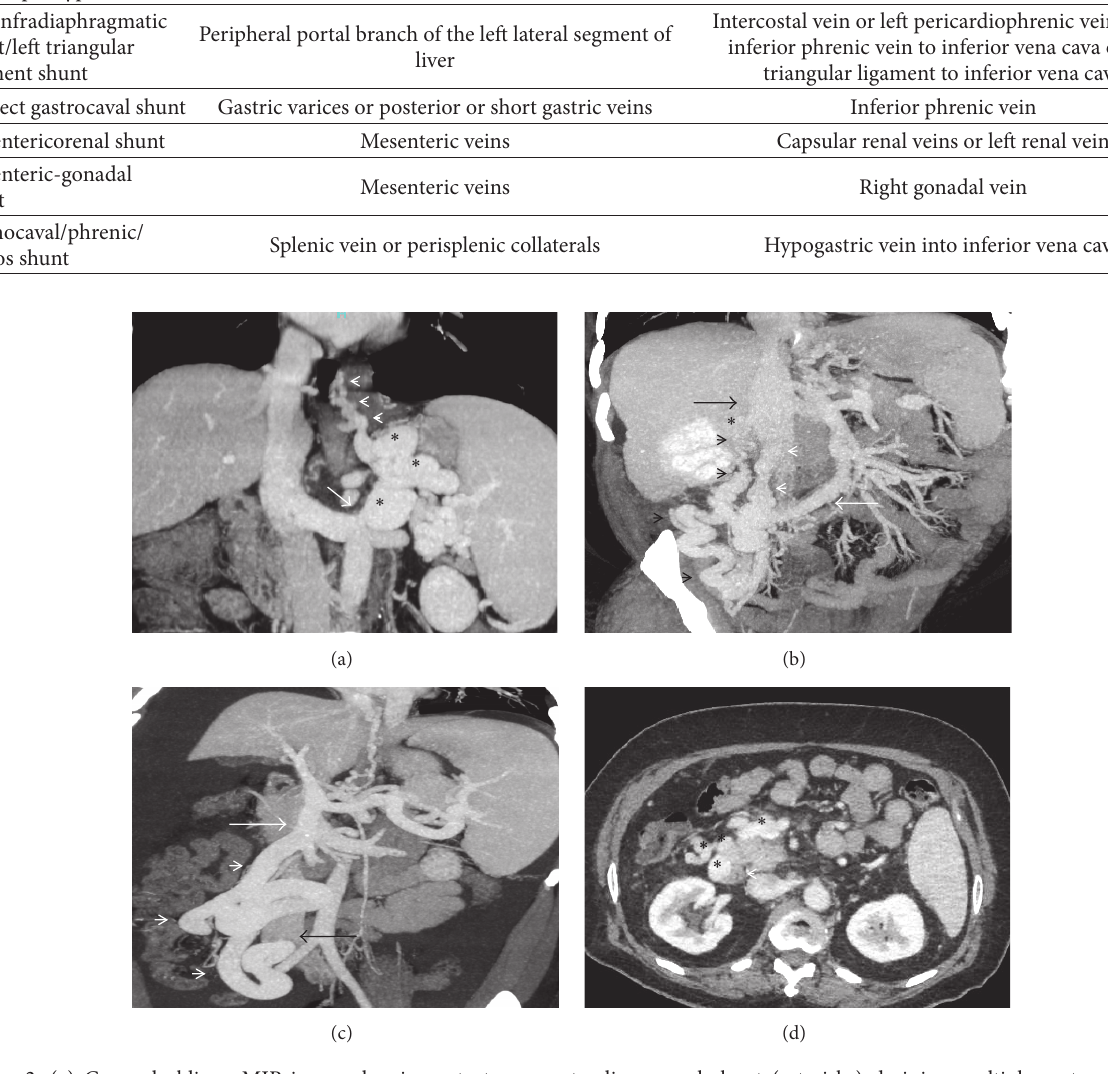
Figure 2: (a) Coronal-oblique MIP image showing a tortuous gastro-lieno-renal shunt (asterisks) draining multiple gastroesophageal collaterals (arrowheads) into the superior aspect of the left renal vein (arrow); (b) coronal MIP image demonstrating a mesentericorenal and a mesentericocaval shunt in the same patient (black and white arrowheads, resp.). Asterisk: right renal vein, black arrow: IVC, and white arrow: superior mesenteric vein (double portosystemic shunts); (c) coronal-oblique MIP image demonstrating a dilated and tortuous mesentericocaval shunt (arrowheads) communicating between the superior mesenteric vein (white arrow) and the inferior vena cava (black arrow); (d) axial CECT image showing multiple duodenal and paraduodenal collaterals (asterisks). Arrowhead denotes the